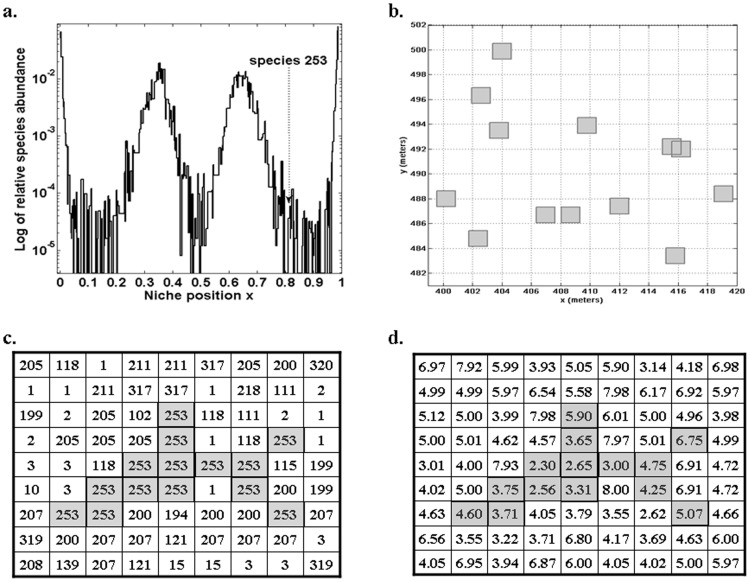
Relation between species rarity and spatial aggregation for Spachea membranacea at Barro Colorado in the 1995 and model species # 253.Both species have the highest spatial aggregation, as measured by the aggregation index Ω0→10 and the same abundance of 14 individuals. a. The clumpy distribution of relative abundance of species in the finite niche axis, showing that species # 253 (niche position x = 0.8179) lies in a gap between clumps of coexisting species. b. The observed distribution of Spachea membranacea at Barro Colorado in the 1995 census [11], [24] yielding Ω0→10 = 689.3. c. Spatial distribution of a model species # 253 in grey. The selected 9×9 sublattice shows the species identity of individuals in the immediate neighbourhood containing all 14 individuals of model species # 253, yielding Ω0→10 = 1031.7. d. The set of fitnesses in the same sublattice containing all 14 individuals of model species # 253. Individuals of the rare species # 253 (in grey) are poorer competitors because they have lower fitnesses than most of their immediate neighbours.